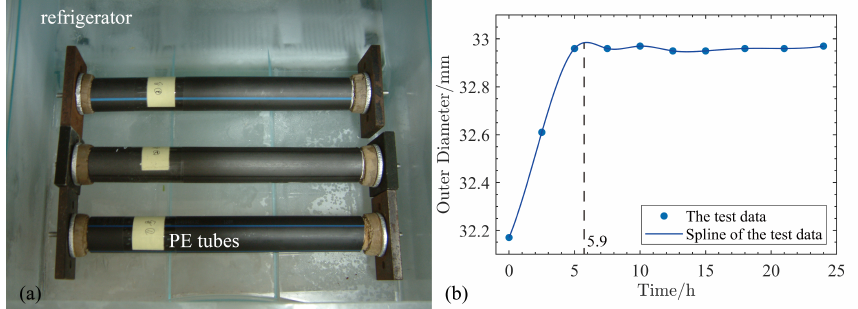
Figure 7. The anti-freeze experiment using PE tubes. ( a ) The photo of the experimental setup. ( b ) The expanding curve of the average outer diameters of the PE